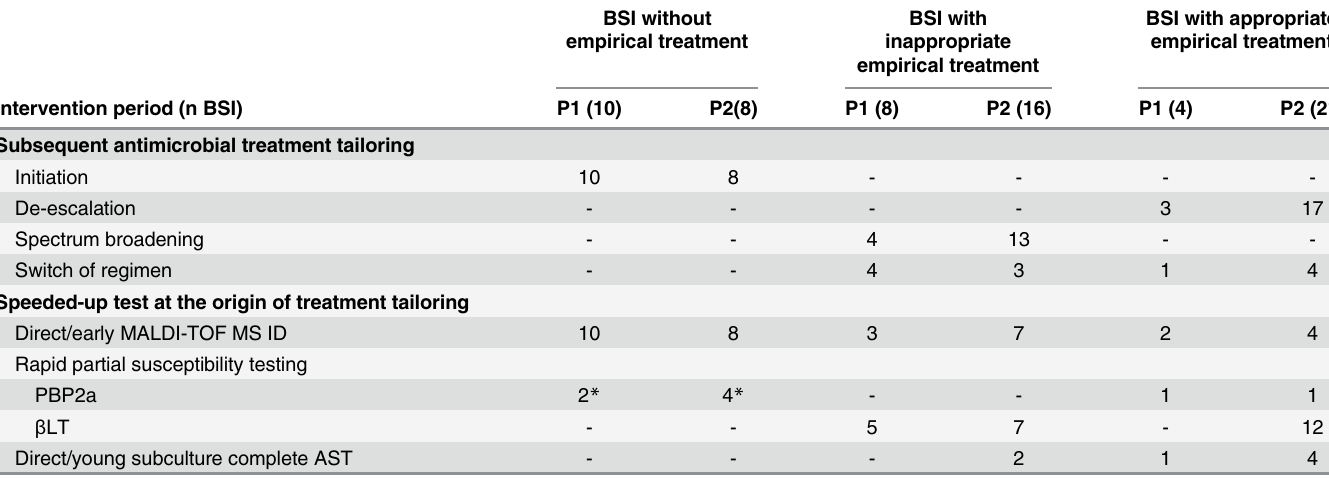
Table 3. Effective antibiotic treatment tailoring of bloodstream infections in both intervention periods following accelerated laboratory